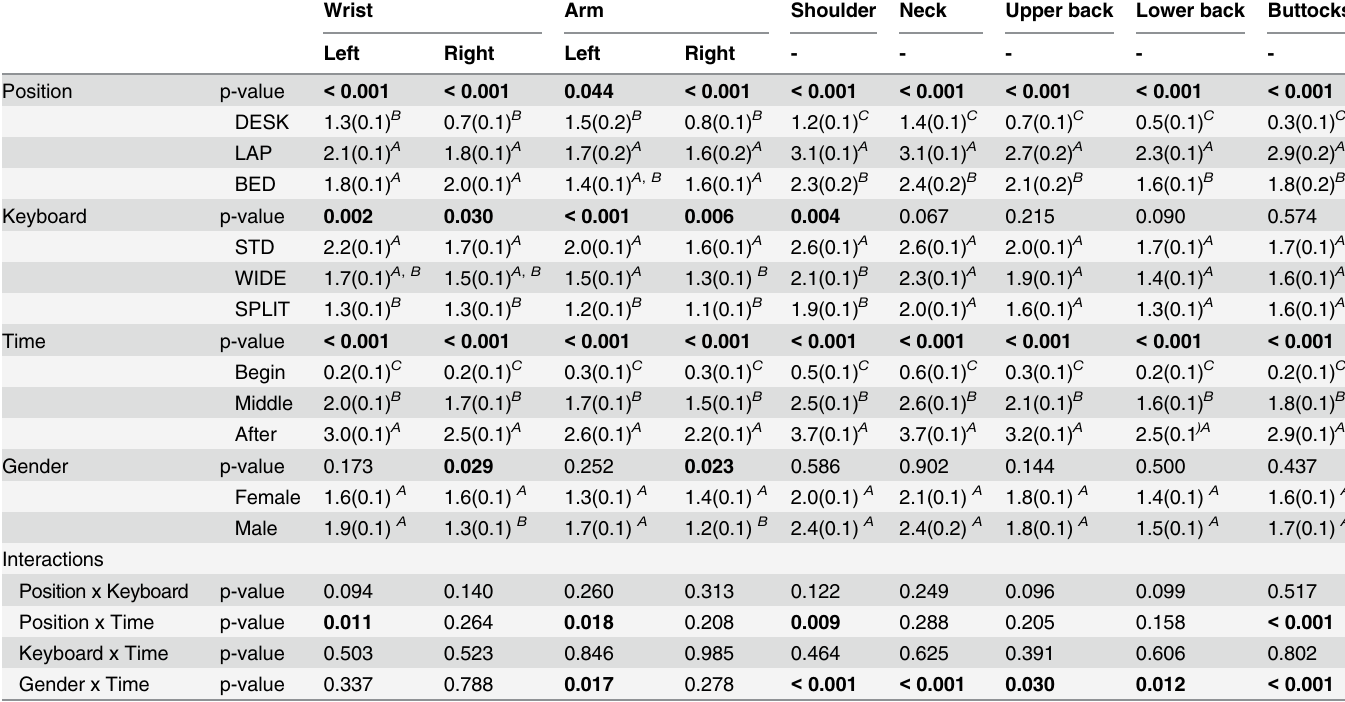
Table 3. Mean (SE) of body discomfort ratings in Borg CR-10 scale for rANOVA main effects Position, Keyboard, Time, Gender and p-values for the interactions 1 2